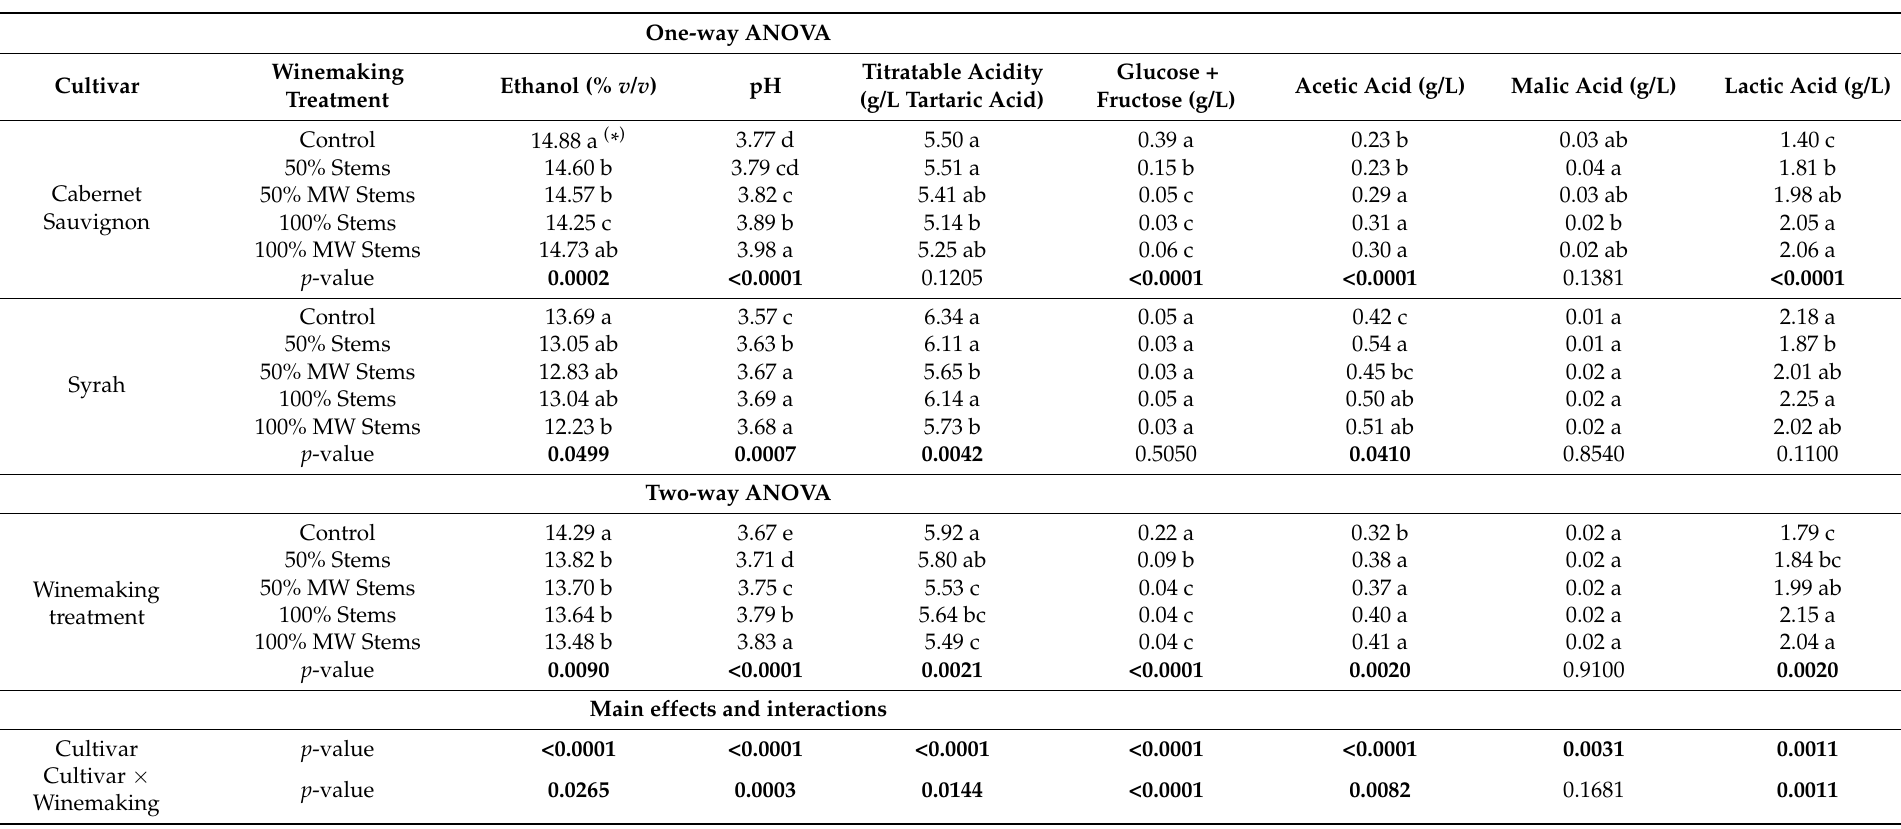
Table 4. One-way and two-way analysis of variance (ANOVA) separating the effects of cultivar and winemaking treatment on the basic chemical composition of Cabernet Sauvignon and Syrah wines from the 2017 vintage. Values represent the mean of three tank replicates ( n =